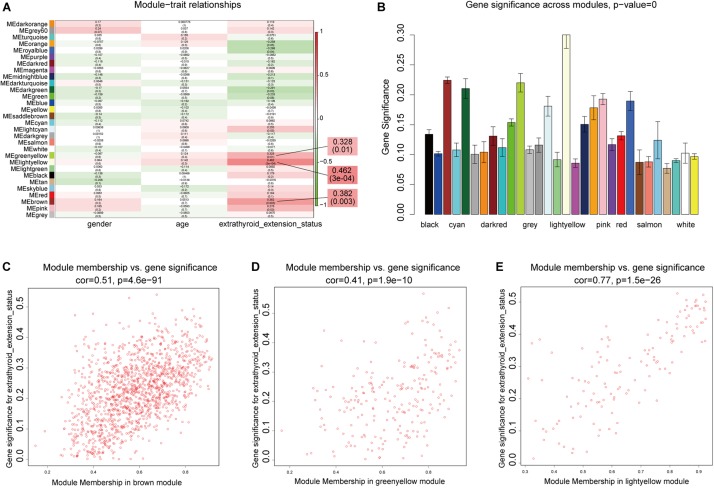
Identification of mRNA modules associated with clinical traits of ETE. (A) Heatmap of module–trait relationships. (B) Distribution of average gene significance in modules related with ETE. (C–E) Scatter plots of correlations between gene module membership and gene significance in the three ETE-related mRNA modules.